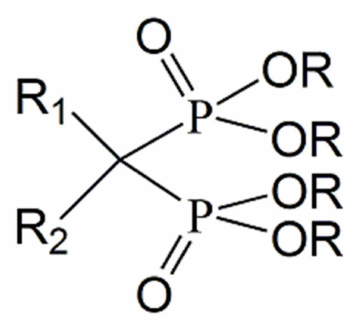
Figure 1. Basic chemical structure of bisphosphonates. The phosphate-carbon-phosphate (P-C-P) bond is the base skeleton of the structure with two covalent side chains (R1 and R2) attached to the germinal carbon. The group R1 allows higher a ffi nity to hydroxyapatite and the group R2 increases the potency of the anti-resorptive capacity and mimic structures that give it di ff erent mechanisms of action, whether as adenosine triphosphate (ATP) analogues or isoprenoid pyrophosphate [41]. Bisphosphonate-based compounds have essential and relevant pharmacological